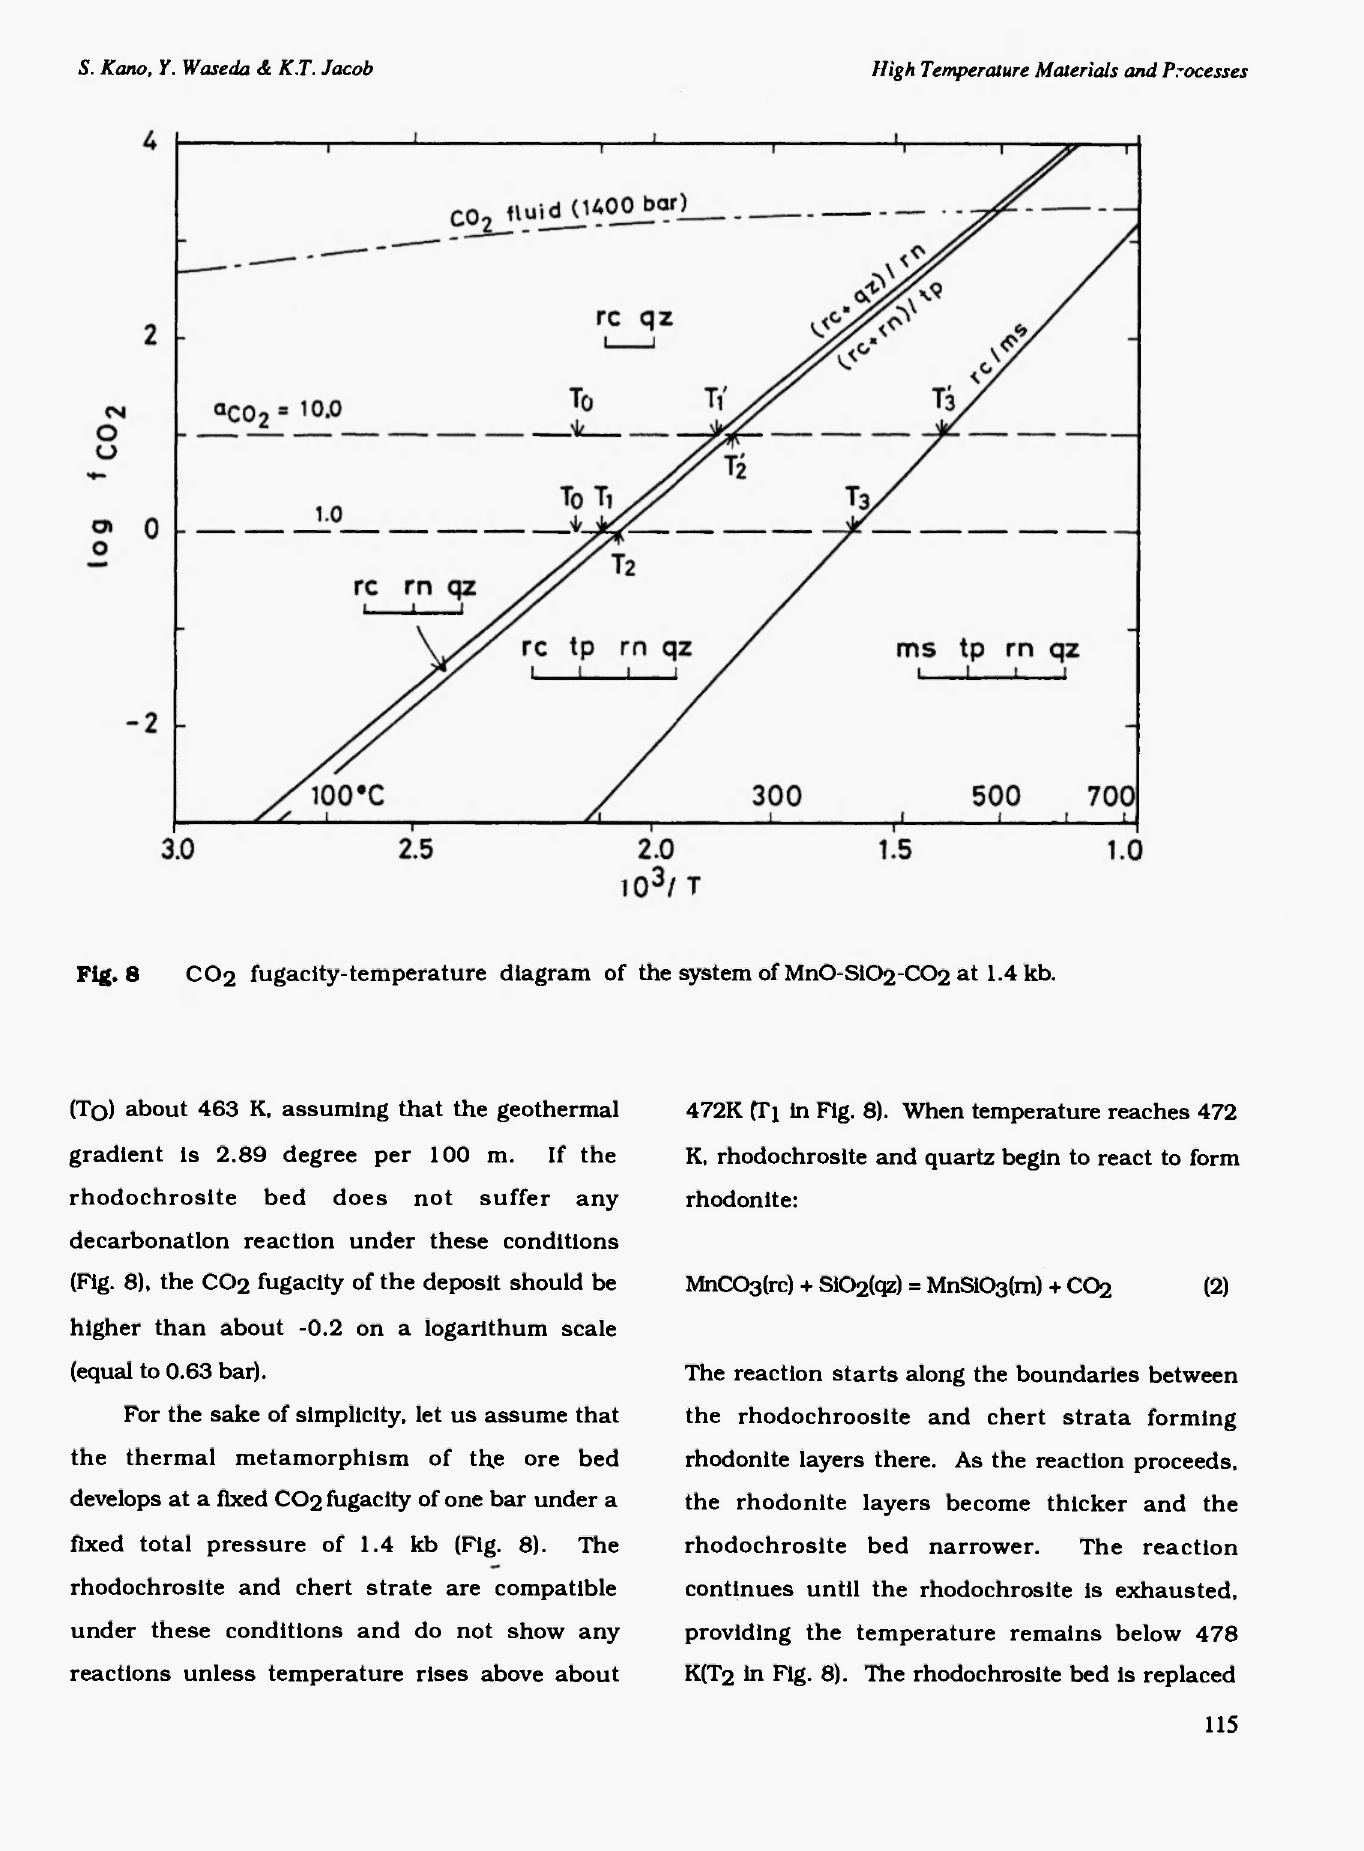
Fig. 8 CC >2 fugaclty-temperature diagram of the system of Mn0 -SiC >2-C02 at 1.4 kb.